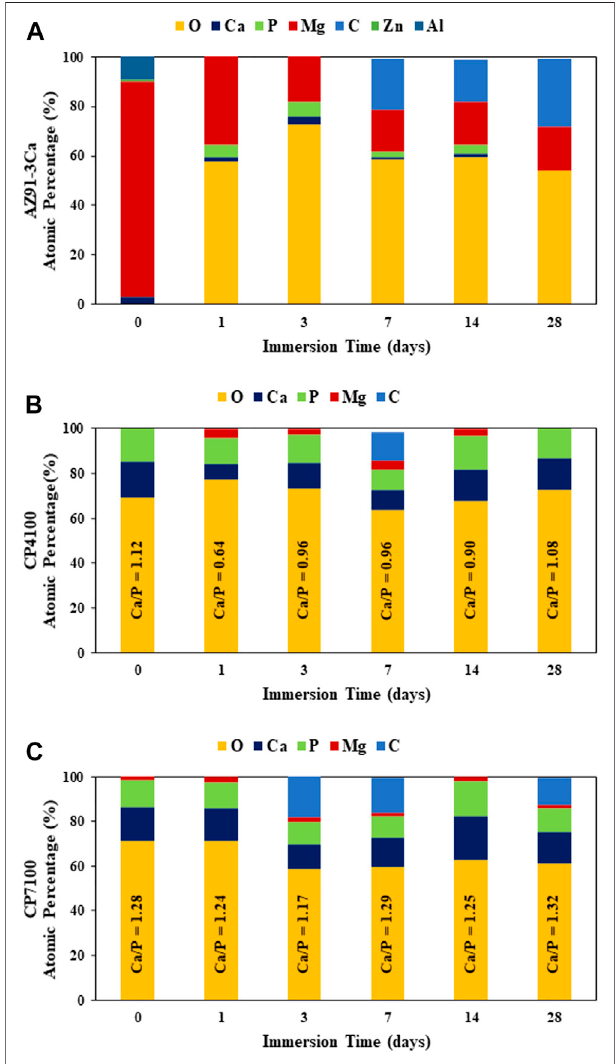
FIGURE5| Surfaceelementalcomposition(at%)ofsamples,beforeand after immersion at prescribed time points in SBF for 28 days, quanti fi ed on respectiveSEMimagesof Figure3 at × 250magni fi cationusingEDSanalysis, (A) Bare AZ91-3Ca alloy (B) CP4100 coated alloy (C) CP7100 coated